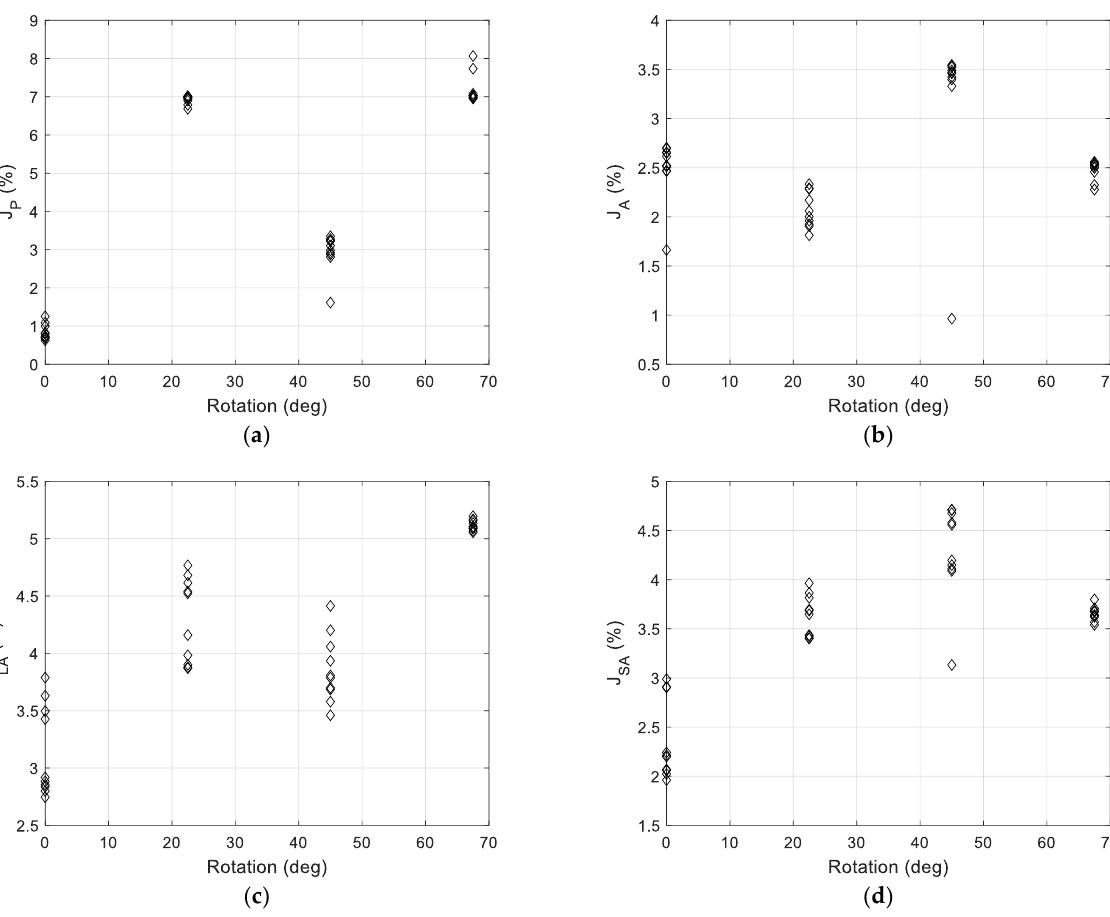
Figure 9. Results of the robustness test for particle rotation angle: relative residuals between the estimated and nominal values of each parameter vs. the rotation angle for ( a ) perimeter, ( b ) area, ( c ) long and ( d ) short axis.